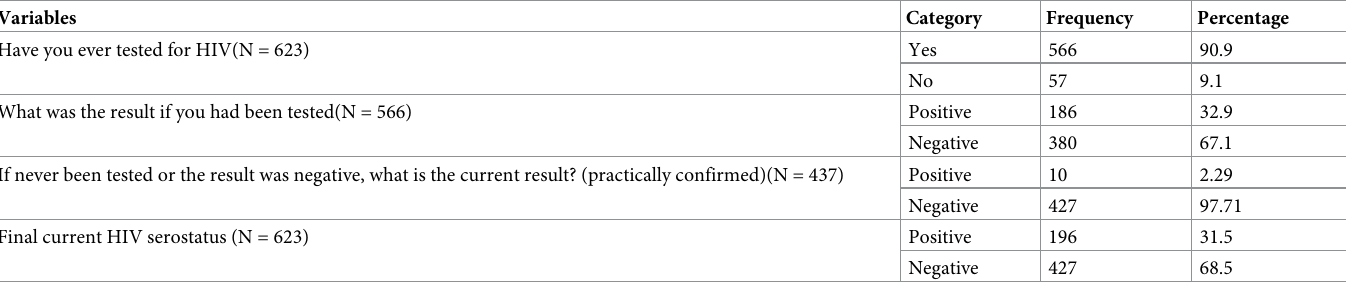
In a sub-group analysis of the spousal partners (N = 217) nearly one-fourth (23%) had STI symptoms or a history of STI in the 12 months prior to data collection. All (100%) heard about HIV testing and counseling service provision and thought testing would be important to fam- ily members of PLHIVs. A majority (98.2%) of them were ever tested, and 149 (70%) had HIV Table 3. HIV serostatus and testing history-related factors of family members of index cases in Sodo Town, Southern Ethiopia, 2021.